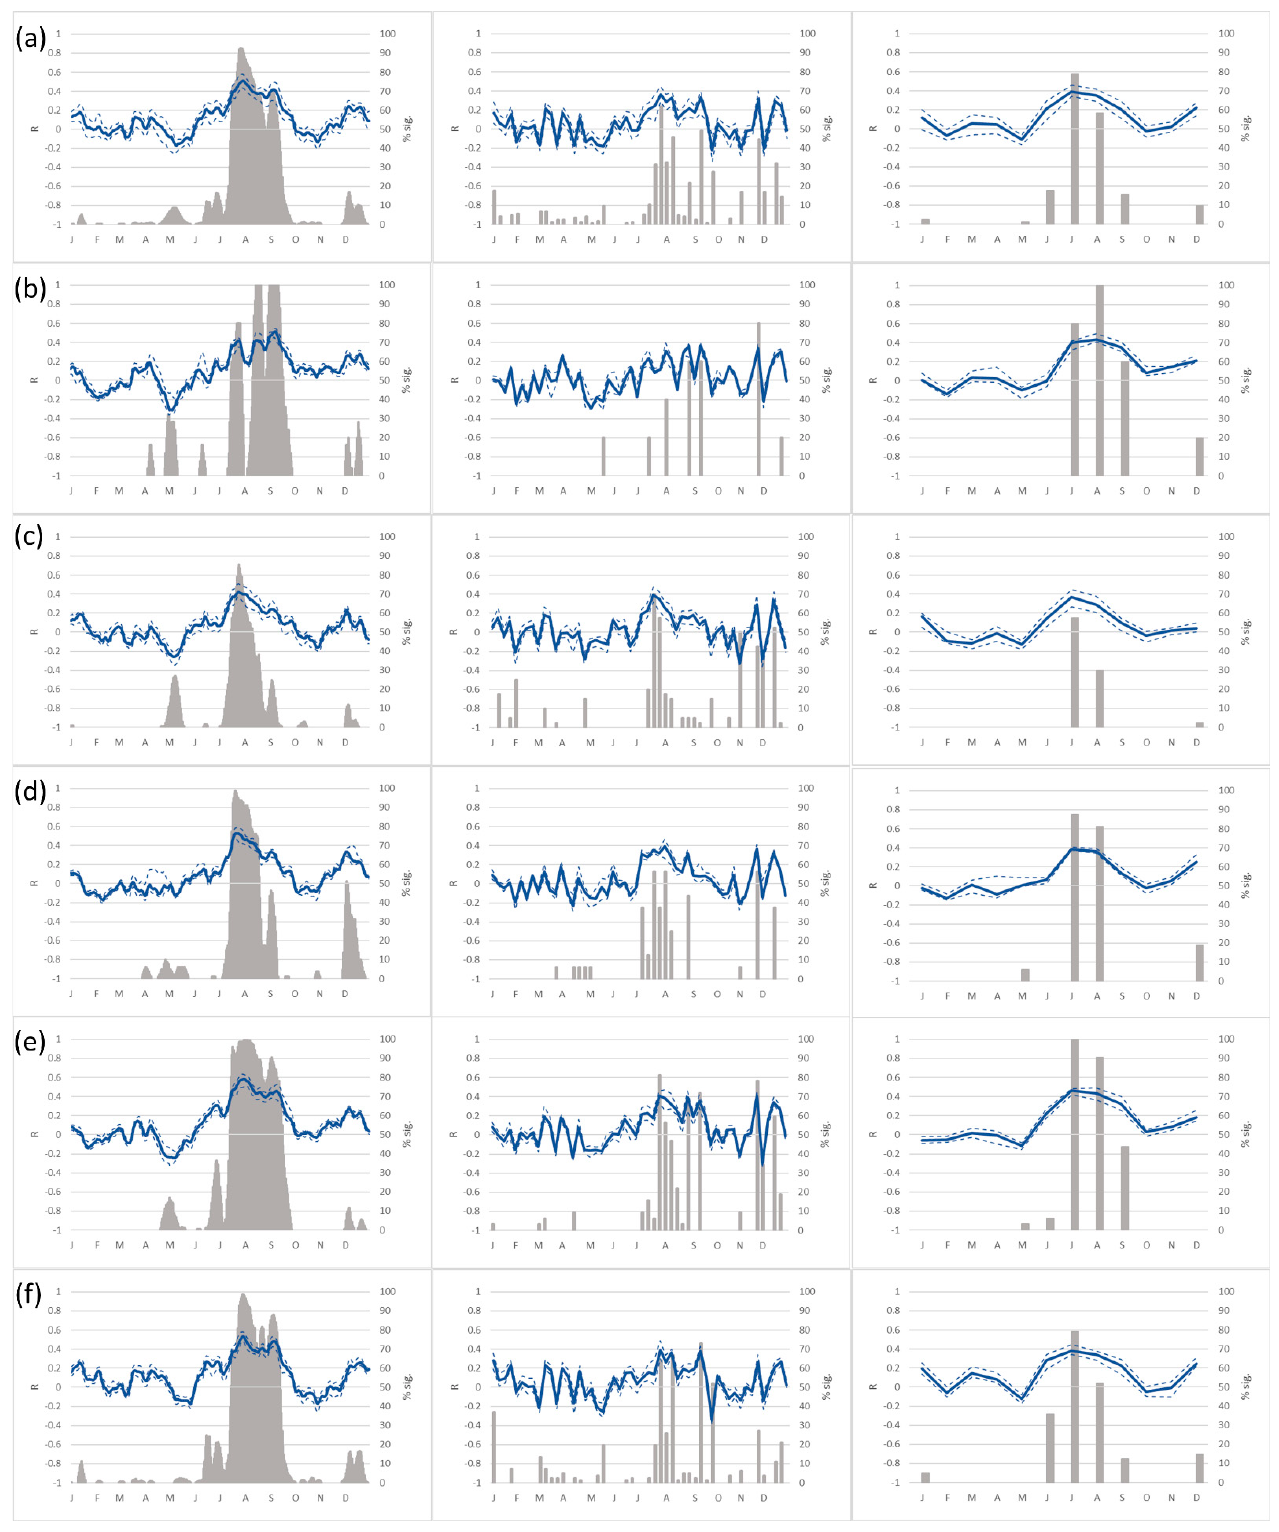
Figure 5. Temporal evolution of percentile 75, percentile 25 (dashed blue lines), median (dark blue line), and percentage of R values with p value < 0.05 (grey bars) obtained with the sample-by-sample approach between precipitation and black truffle production for daily data (left column), weekly data (middle column) and monthly data (right column). ( a ) Iberian Peninsula; ( b ) Betic Range; ( c ) Pyrenees; ( d ) North Iberian Range; ( e ) Central Iberian Range; ( f ) South Iberian Range.